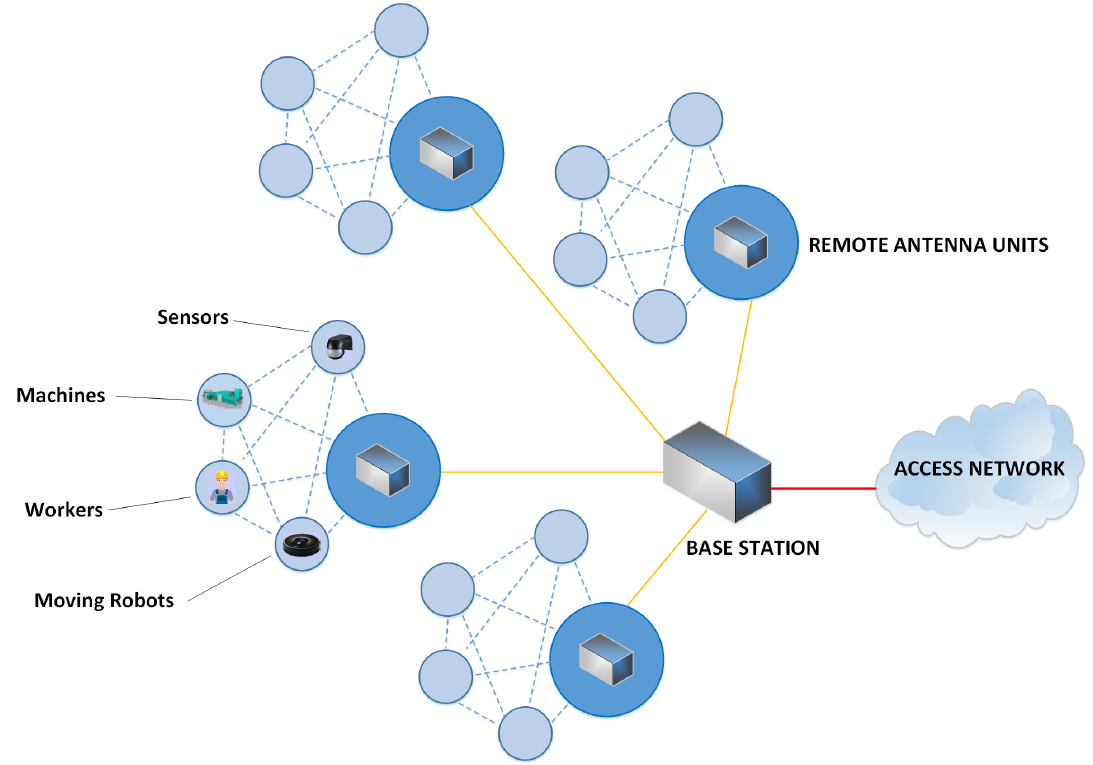
Figure 1. Scheme of a distributed antenna